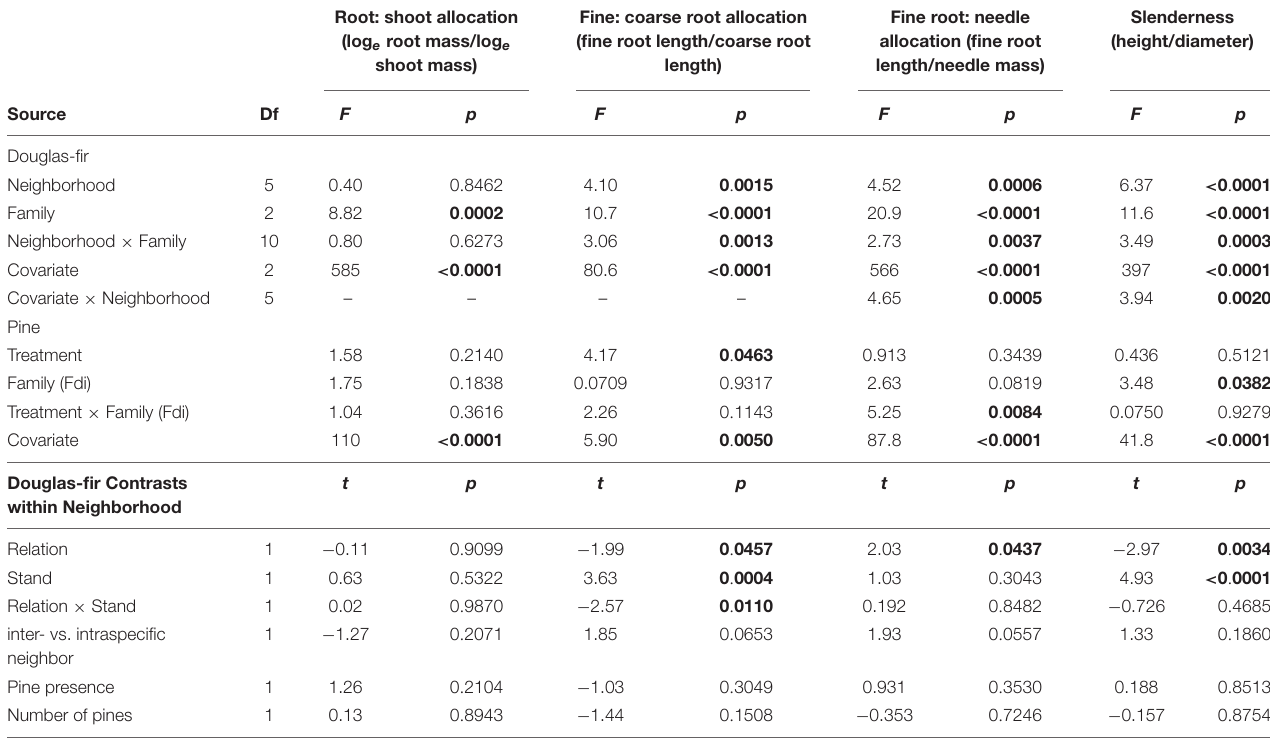
TABLE 2 | Allocation and complex morphological trait analyses for groups of interior Douglas-fir (Fdi) grown in pots, taken from equivalent analyses of covariance (e.g., root: shoot ratio is analyzed with root mass as the dependent variable and shoot mass as the covariate).